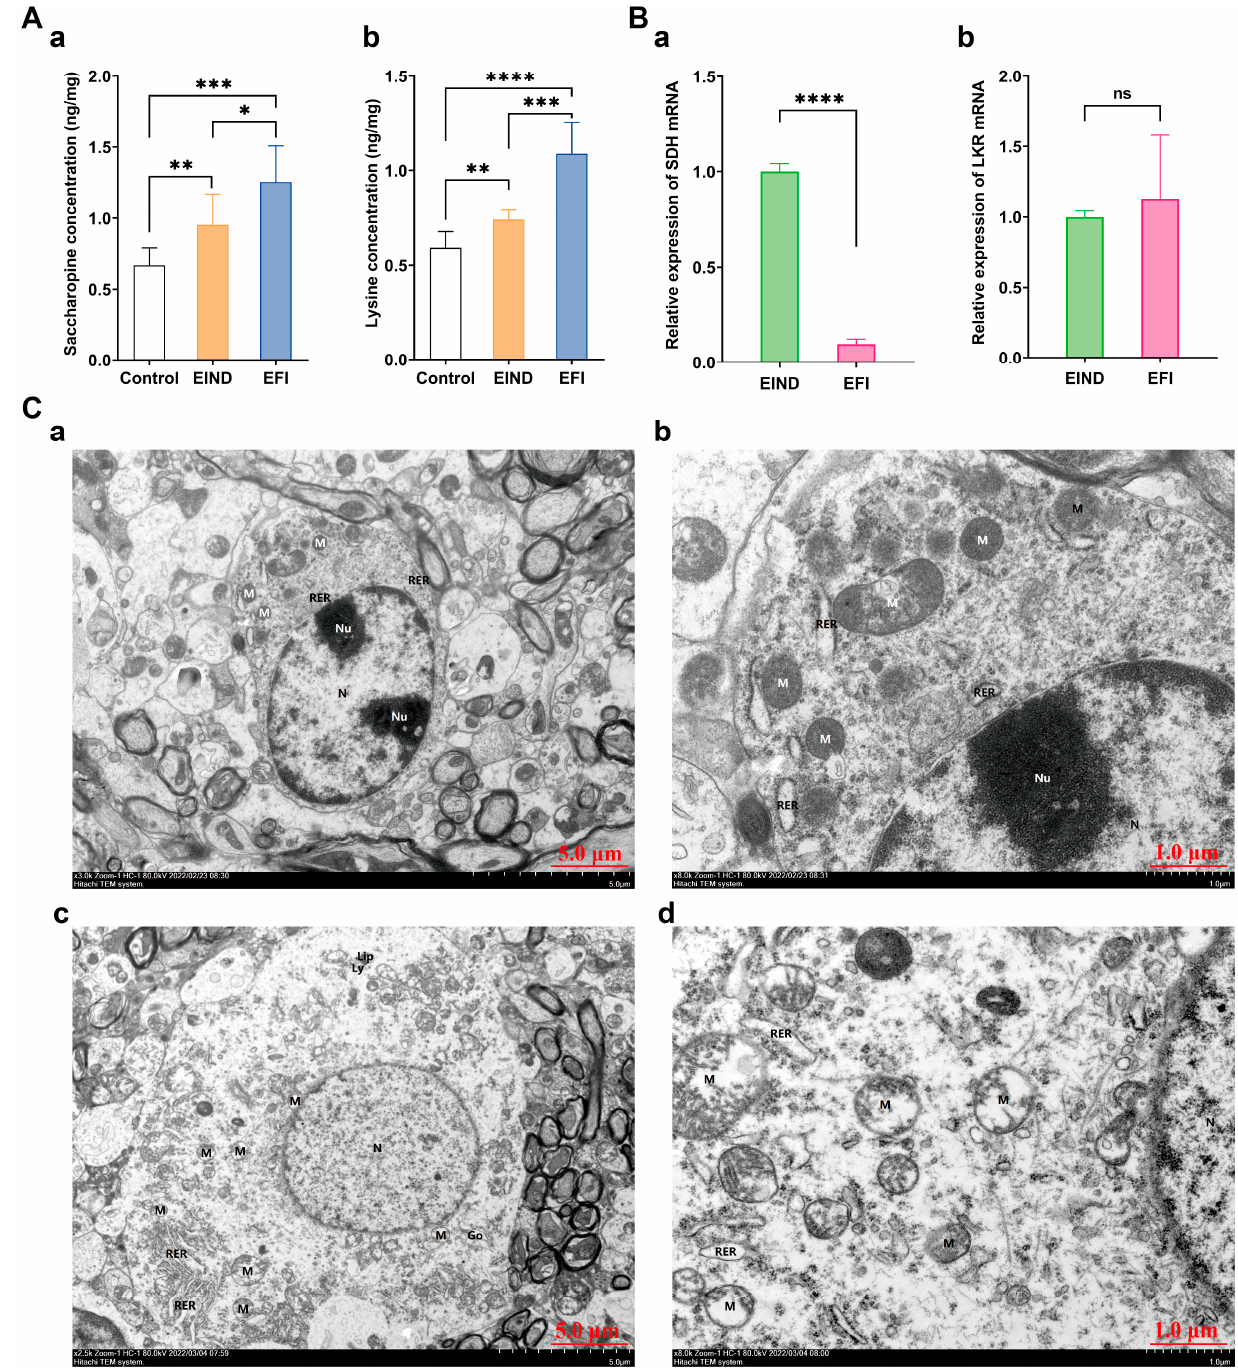
Figure 9. Validation of a new mechanism of estazolam toxicology. ( A ) Quantitative analysis of sac- charopine ( a ) and lysine ( b ) between the EFI and EIND and control group (n animal = 10, respectively), which were normalized to the WT (weight, 50mg brainstem tissue) value: *: p < 0.05; **: p < 0.01; ***: p < 0.001; and ****: p < 0.0001. ( B ) Histogram of relative expression of SDH and LKR mRNA in two sets of brainstem samples (n animal = 10, respectively): ****: p < 0.0001; ns: no statistically significant difference. (a) Histogram of relative expression of SDH mRNA between EFI and EIND groups. (b) Histogram of relative expression of LKR mRNA between EFI and EIND groups. ( C ) Brainstem ul- trastructure between EFI and EIND groups (n animal = 3, respectively); ( a ) brainstem ultrastructure of EIND group, bar = 5 µm; ( b ) EIND group, bar = 1 µm; ( c ) brainstem ultrastructure of EFI group, bar = 5 µm. ( d ) EFI group, bar = 1 µm. ( a , b ) The double nucleolus (Nu). The mitochondria (M) were mostly round, some were mildly swollen, individual membranes were broken, the matrix was a